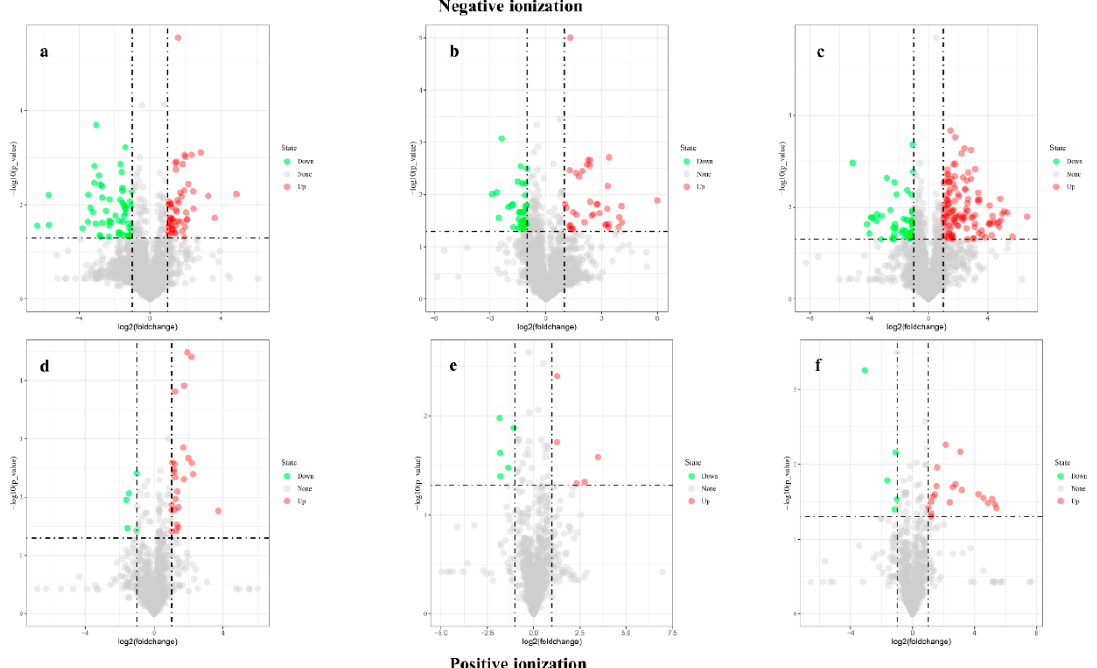
Figure 3. Analyze the volcano plots of genotype comparisons in both ionization modes. X > 1 and Y > 1.30 represent significant increases, while X < − 1 and Y > 1.30 represent significant decreases. ( a , d ) A1 vs. X1, ( b , e ) B1 vs. Y1, ( c , f ) C1 vs. Z1. Red color indicates significant increases in metabolites and green indicates a significant decrease in